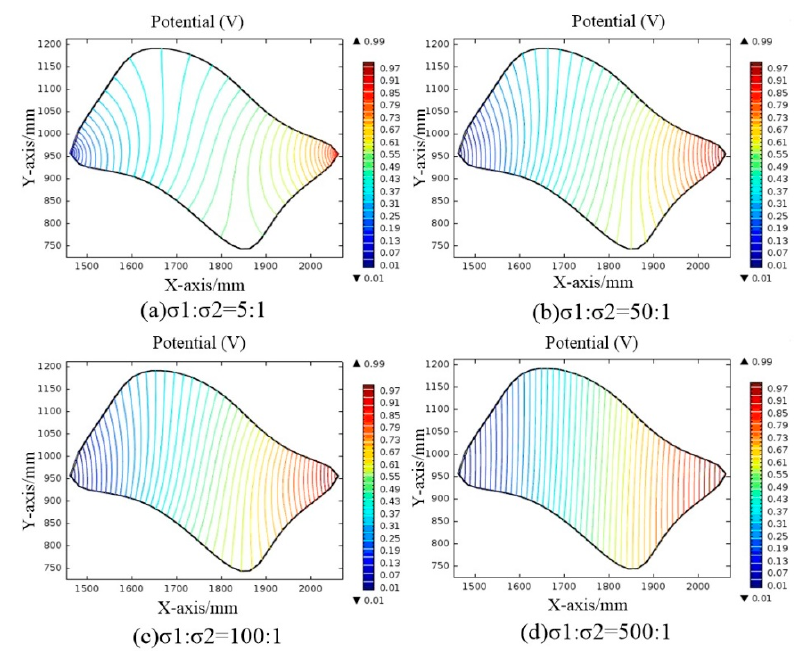
Figure 9. Potential distribution in the conductive plane with different conductivity ratios.